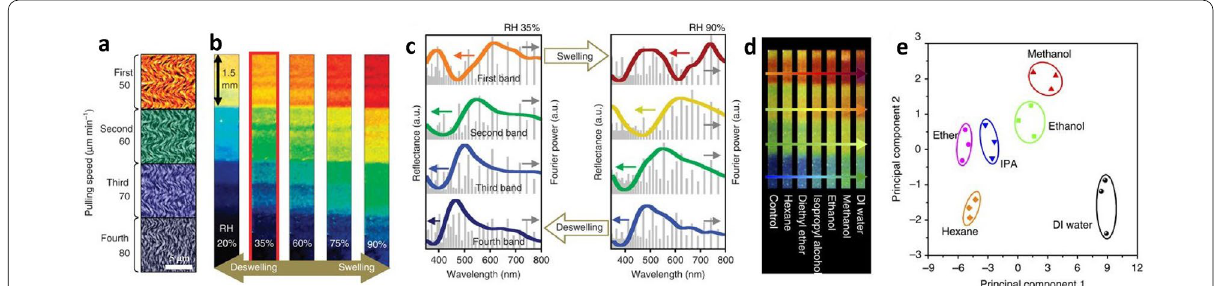
Fig. 4 Colour band generation and structural modulation regarding gas exposure. a Composite of Atomic force microscopy (AFM) images from different matrices of colour band. Each matrix is composed of quasi‑ordered fibre bundles with different diameters and interspacings and exhibits a different colour. b A fabricated colour band exhibiting four distinct colours: orange, green, blue, and deep blue (in red box). Changes in relative humidity (RH) result in changes in colours. Depending on the initial phage‑bundle structure, each phage matrix swells with a different ratio and exhibits a different colour change. c Reflectance spectra (coloured lines) at a normal angle and Fourier power spectra (grey bars) of each phage matrix in 35 and 90% RH; these generally correspond to each other in hue (position of peak) and chroma (shape of the peak; a.u., arbitrary units). d Photographs of the colour band after exposure to hexane, diethyl ether, isopropyl alcohol, ethanol, methanol, and DI water. e Principal component analysis plot of the colour changes resulting from the exposure of the colour band to different VOCs ( a – e Reproduced with permission from